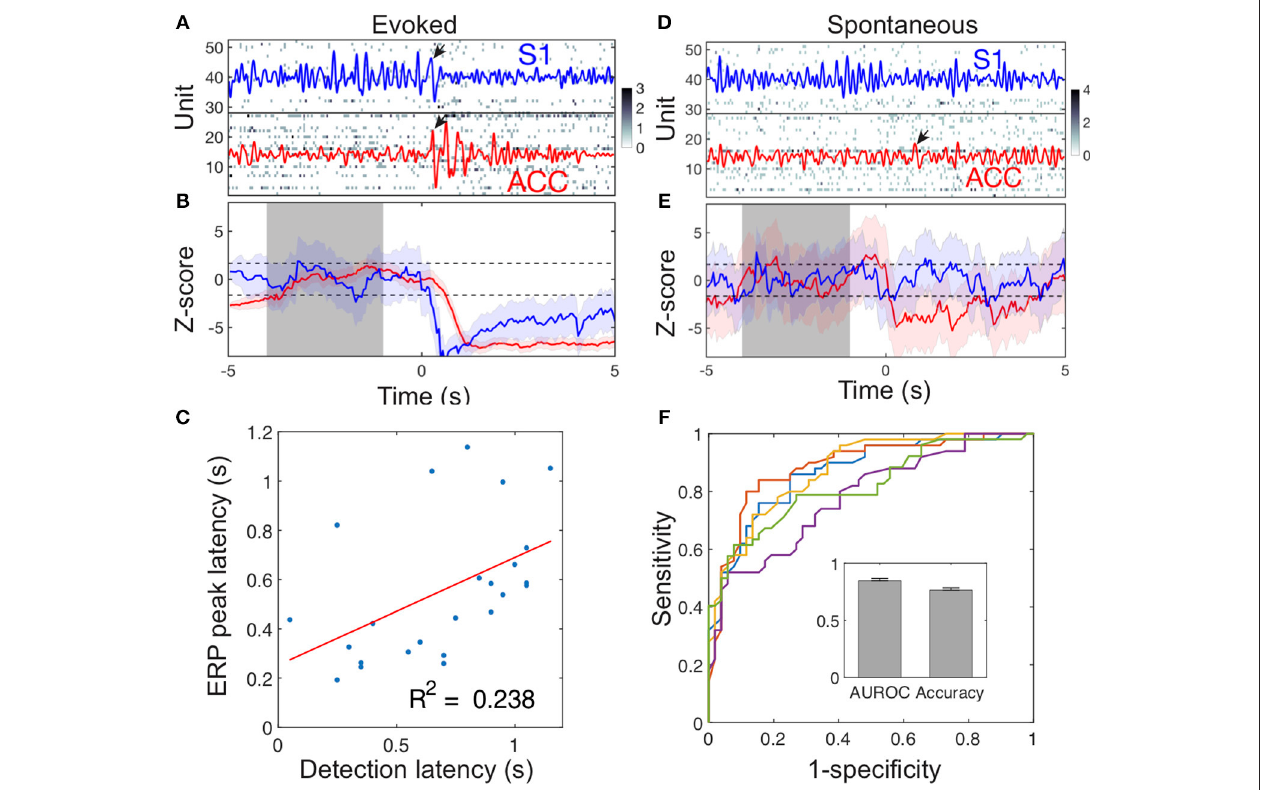
FIGURE 6 | Illustration of detecting acute and spontaneous pain-like events. (A) The simultaneous ACC and S1 ensemble spike activity during a laser-evoked pain episode. Dark pixel represents high spike count. Time 0 denotes the onset of 250 mW laser stimulation. The ACC (red) and S1 (blue) LFPs were overlaid in the spike raster. Pain-induced ERPs are marked by arrows. In this example, the S1 ERP peak occurred 30 ms earlier than the ACC ERP peak. (B) The evoked pain event was detected based on our previously developed algorithm (Methods). Shaded periods of [ 4, 1] s denote the baseline for computing the Z-score (ACC: red; S1: blue). − − When the upper or lower confidence interval of the Z-score was below or above the significance threshold (horizontal dash lines), the onset of pain signal was detected as a change point. In this example, the detected acute pain onset in the S1 was earlier than the onset in the ACC, whereas the S1 ERP peak latency was also earlier than the ACC ERP peak latency. (C) During evoked pain episodes, the ensemble spike-based acute pain detection latency to the stimulus onset positively correlated with the ERP peak latency ( n 24 trials; p 0.0156, Pearson’s correlation). (D,E) Similar to respective panels A,B , except for a spontaneous pain-like = = episode. Time 0 denotes the onset of paw withdrawal. (F) Receiver operating characteristic (ROC) curves of 5-fold cross-validated SVM classification for spontaneous pain. The AUROC and accuracy statistics (mean SEM) are shown in the ±